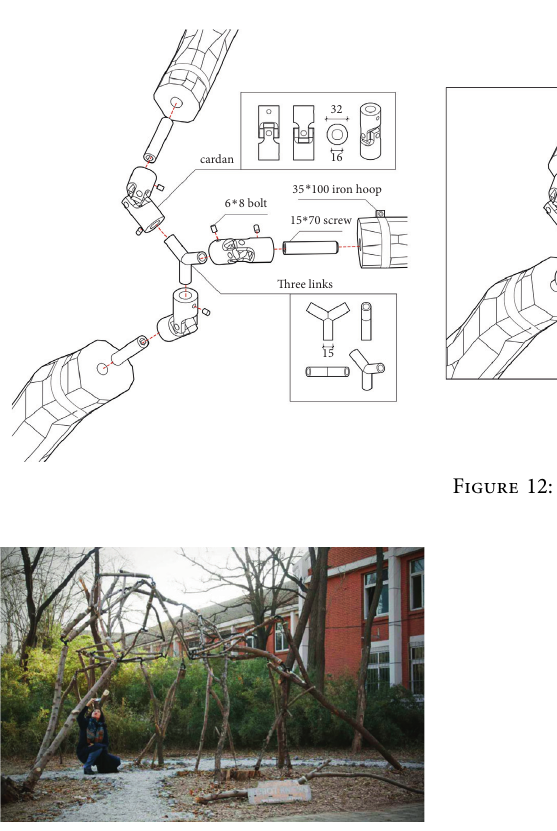
Figure 13: “Robotic knows”